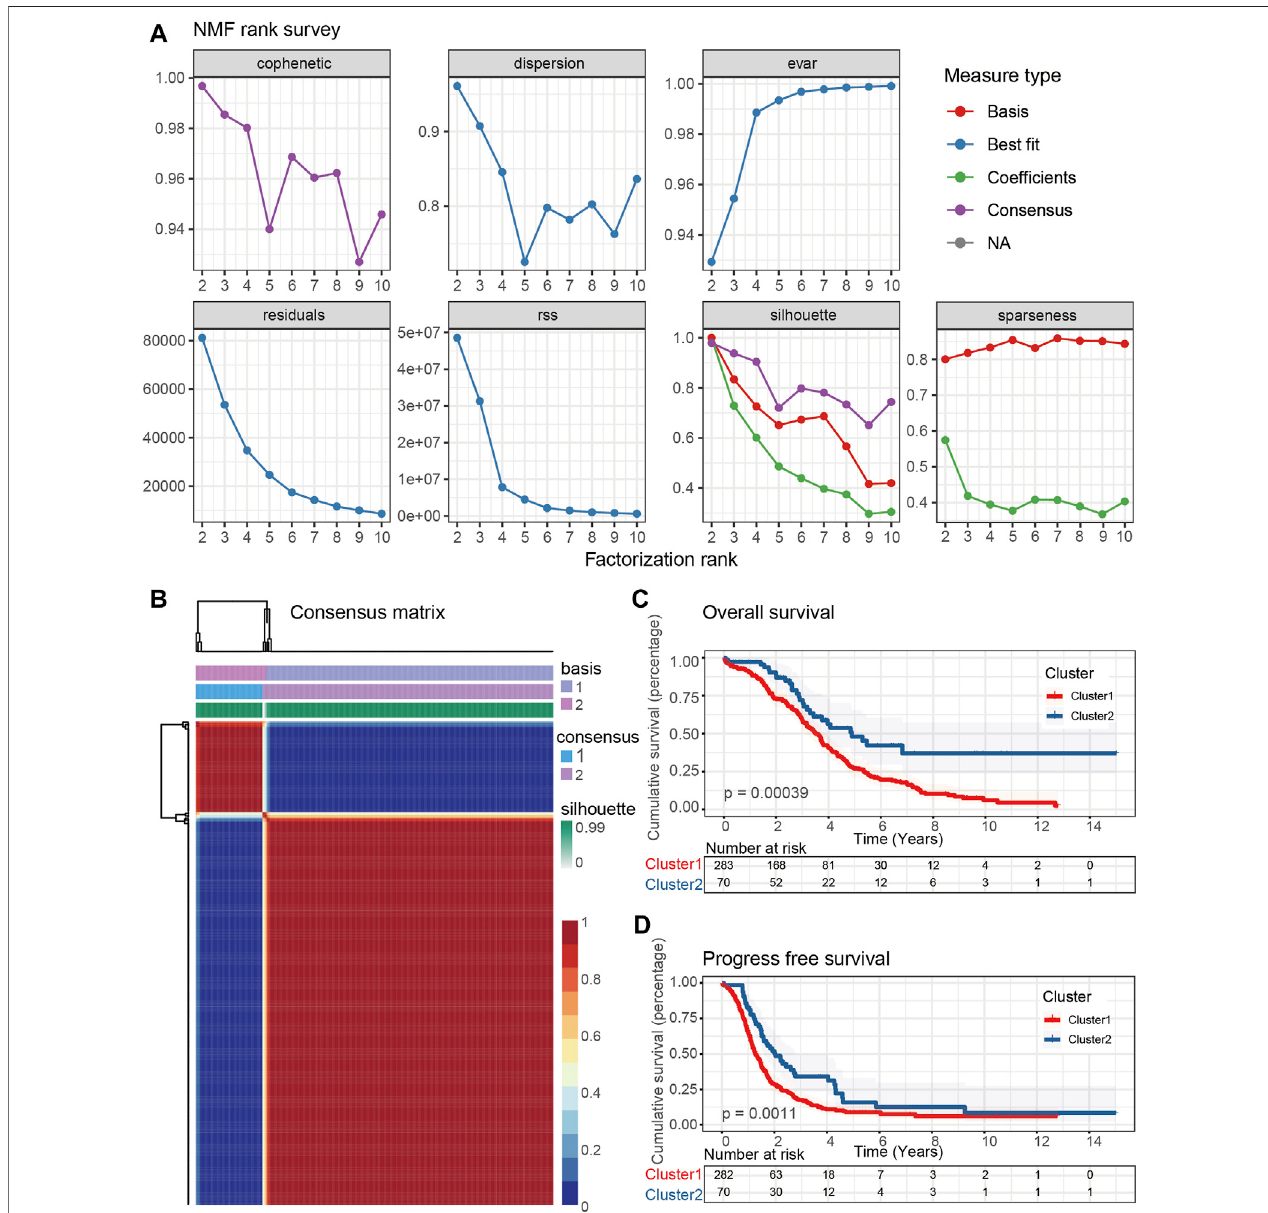
FIGURE 2 | Identi fi cation of the molecular subtypes of OC patients using NMF. (A) The cophenetic, dispersion, evar, residuals, rss, silhouette, and sparseness distributions when rank k was set as 2 to 10. (B) Consensus map of NMF clustering for k = 2, which was the optimal cluster number in the TCGA-OV cohort. Kaplan- Meier (K-M) survival analyses were used to determine the OS (C) and PFS (D) prognosis of OC patients in two sub-consensuses classi fi